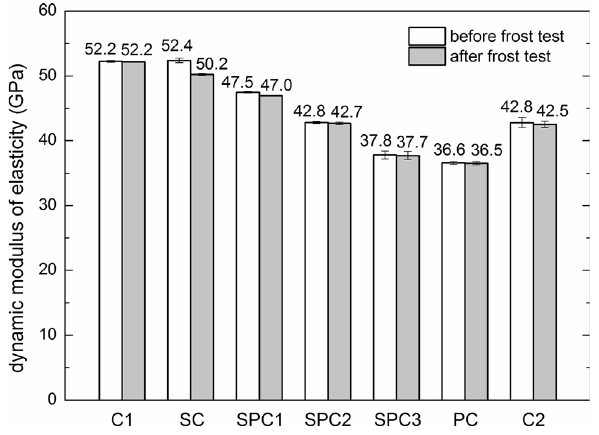
Fig. 11 Dynamic modulus of elasticity before and after freeze–thaw cycles.